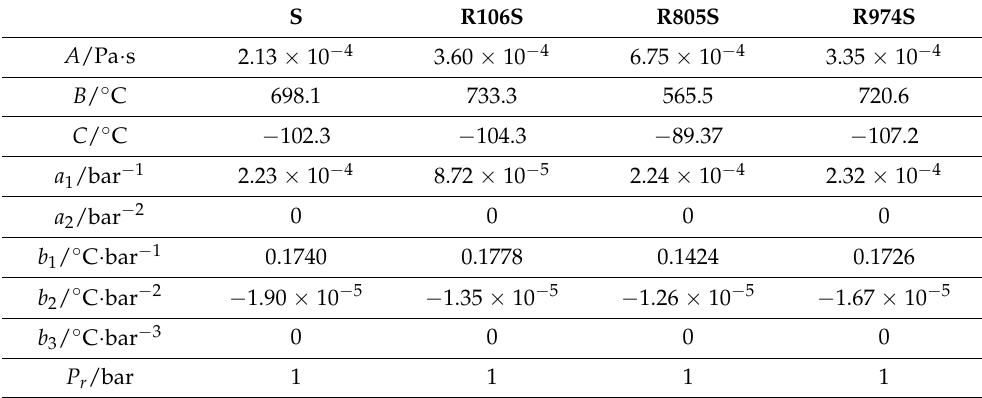
Table 7. Parameters of the VTF model for the analyzed samples.